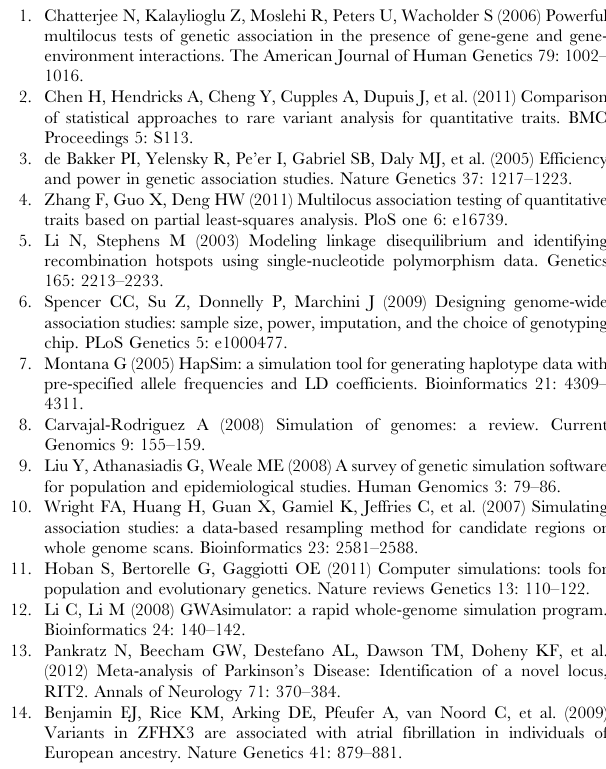
Figure S9 Heat maps of change in median LD for Gene Region 2 by MAF Group. Heat maps of change in median simulated LD from original LD in Gene Region 2 by MAF group (median[LD simulated ] – LD HapMap ). Markers are only included in each plot if both markers fall in the MAF group. Upper left D’, lower right r 2 . Blue indicates a gain in LD; red indicates a loss in LD. (TIFF) Figure S10 Affect of dichotomizing on the correlation between two normally distributed variables with differ- ent cut points. Dichotomized correlation compared to original correlation. Each curve represents an original correlation value ( r =0.1 for the lowest peaked curve to r =0.9 for the highest peaked curve by 0.1). One cut point varied along the x-axis while the other was held constant for each plot. A) c 2 = 2 3, B) c 2 = 2 1.5, C) c 2 =0, D) c 2 = 1.5, E) c 2 = 3 (TIFF)